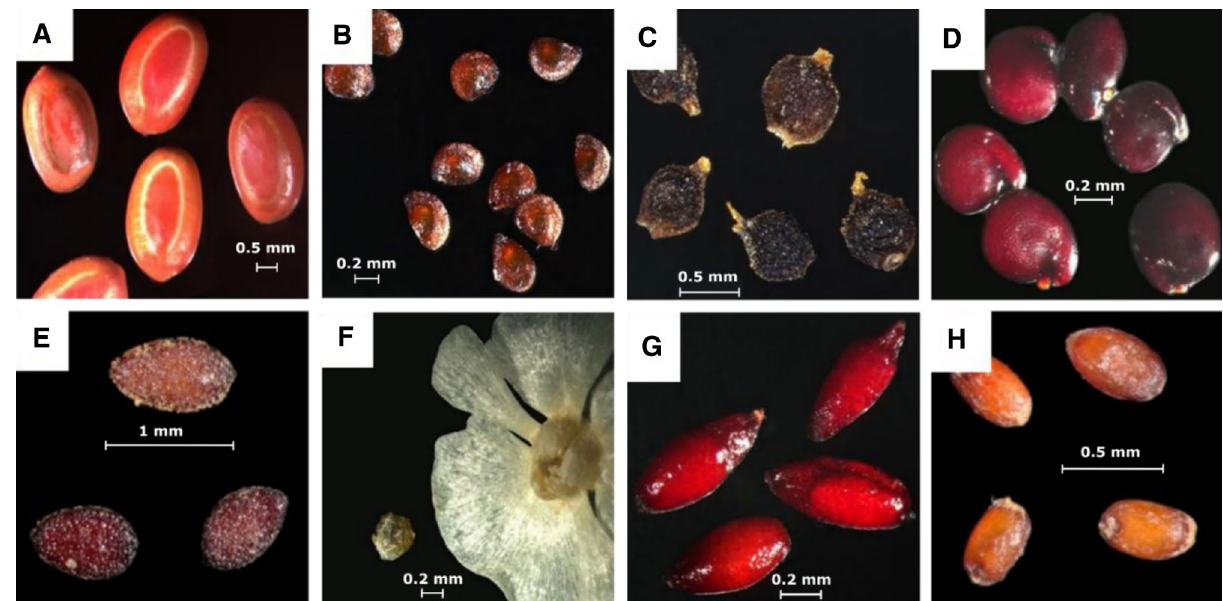
Figure 1. Pictures of seeds of species used in the present study: ( A ) Acacia tortilis, ( B ) Halopeplis perfoliata, ( C ) Salsola setifera, ( D ) Suaeda aegyptiaca, ( E ) Tetraena qatarensis, ( F ) Caroxylon imbricatum, ( G ) Limonium axillare, ( H ) Aeluropus lagopoides.